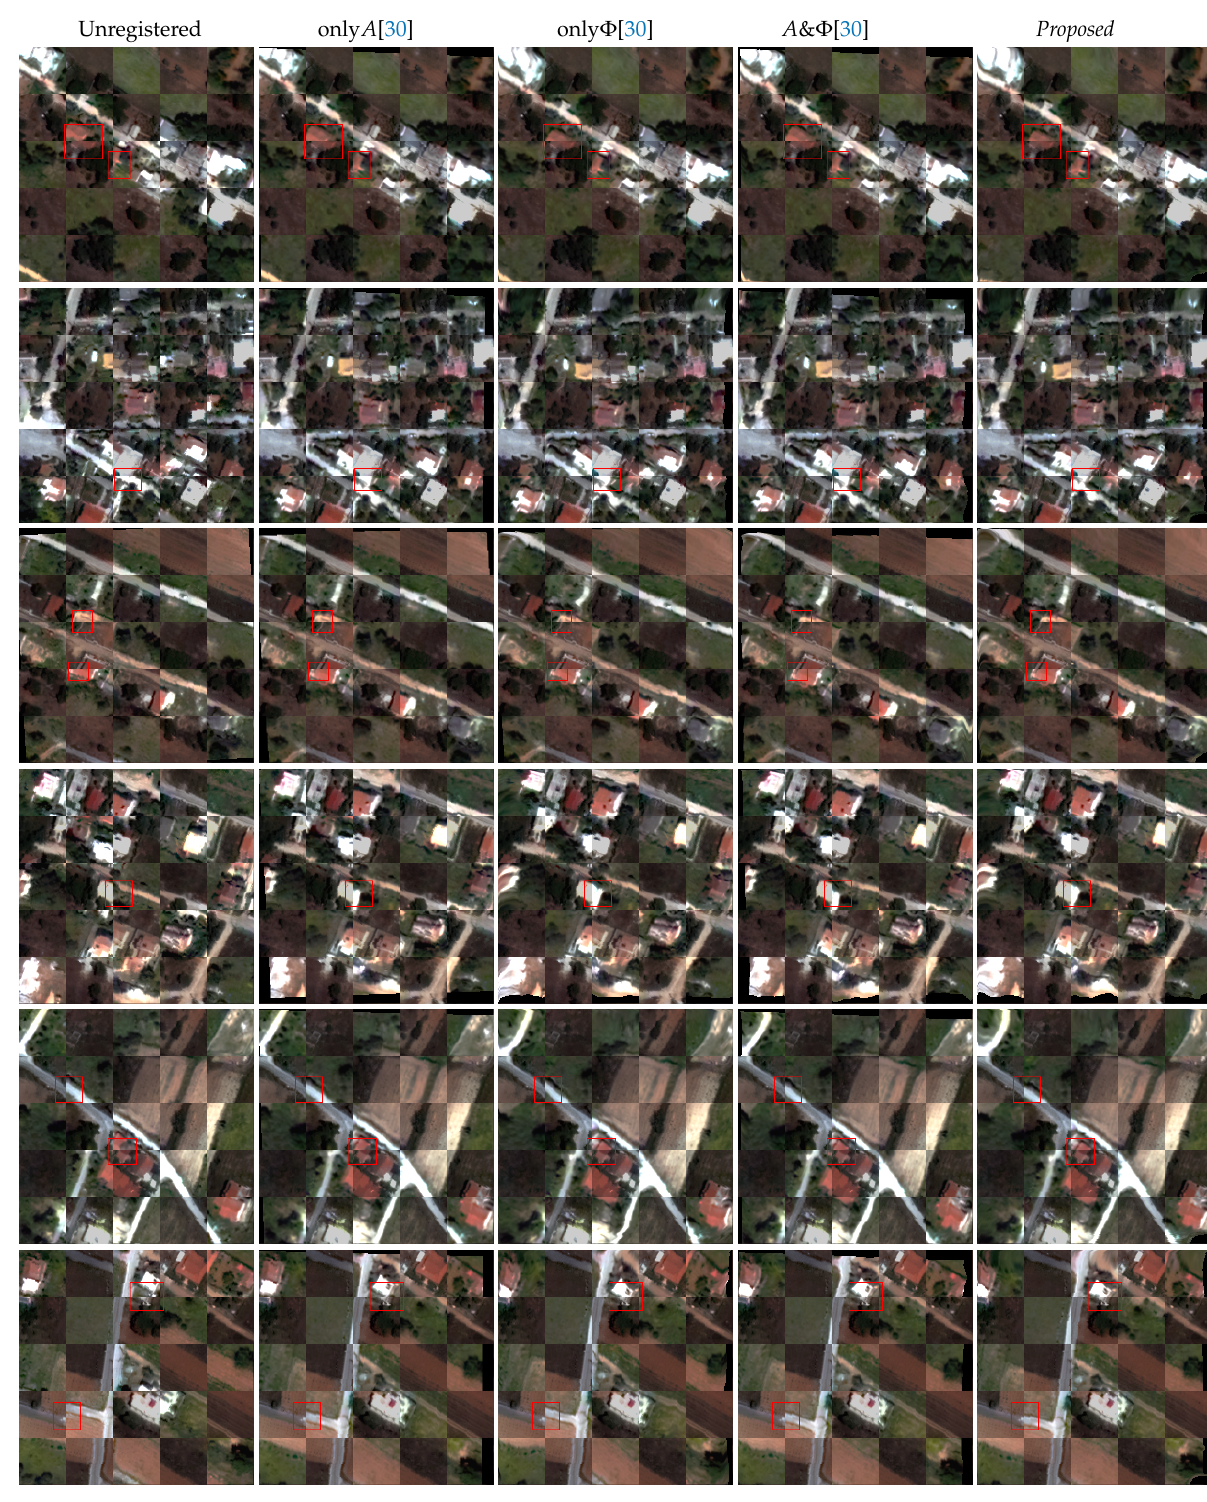
Figure 3. Qualitative evaluation on different pairs from the Attica VHR testing regions. Different approaches from [30] are compared i.e., from left to right: Unregistered raw data, results: only A , only Φ , A & Φ , Proposed .